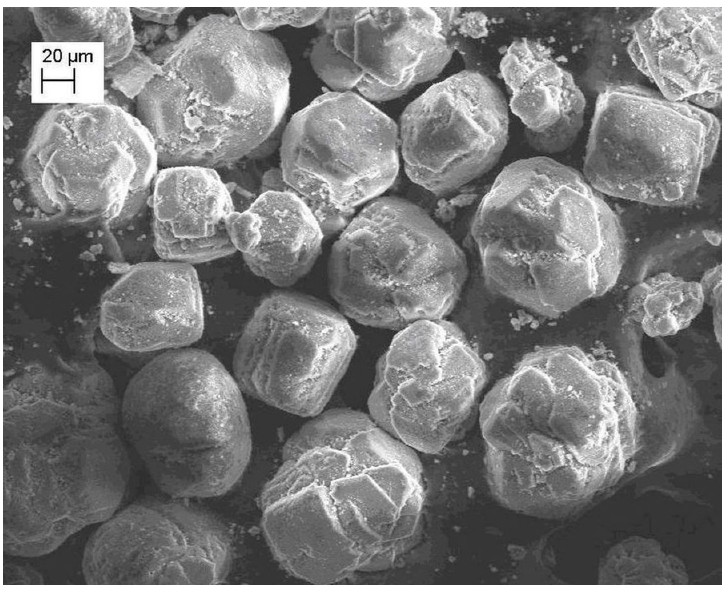
Figure 1. Scanning electron microscopy (SEM) image of the microspherical support.